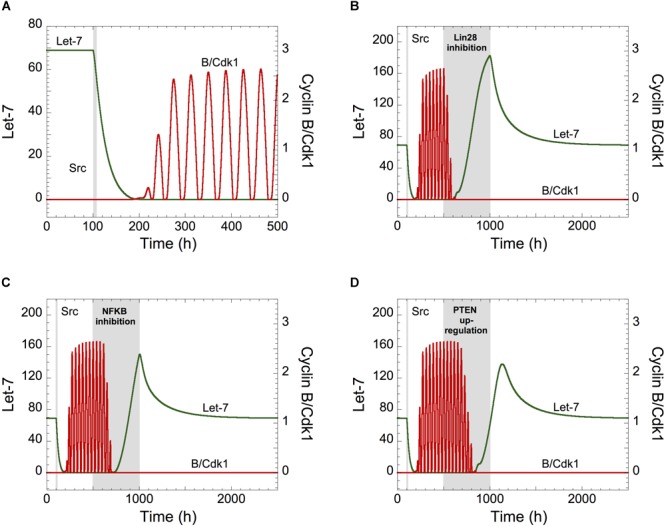
Let-7 is a central component between the proliferation and a malignant transformation network. (A) Effect of the inflammatory circuit on the Cdk network dynamics. (A–D) Starting from a non-transformed, quiescent, cell state, defined by high Let-7 and low cyclin B/Cdk1 levels, a transient increase in Src from t = 100 h to t = 105 h (gray area) triggers an epigenetic switch and cell proliferation characterized by Let-7 down-regulation and sustained oscillations of cyclin B/Cdk1. From that transformed, cell proliferative state, the temporal evolution of Let-7 and cyclin B/Cdk1 is illustrated in the presence of transient (B) Lin28 inhibition (VSLIN28 passes from 0.1 to 0 for 500 h < t < 1000 h), (C) NF-κB inhibition (kAA1NFKB = kAA2NFKB = kAA3NFKB = 0 for 500 h < t < 1000 h), or (D) PTEN over-expression (VSMPTEN passes from 0.001 to 10 for 500 h < t < 1000 h). Other parameter values are as in Supplementary Table S5.